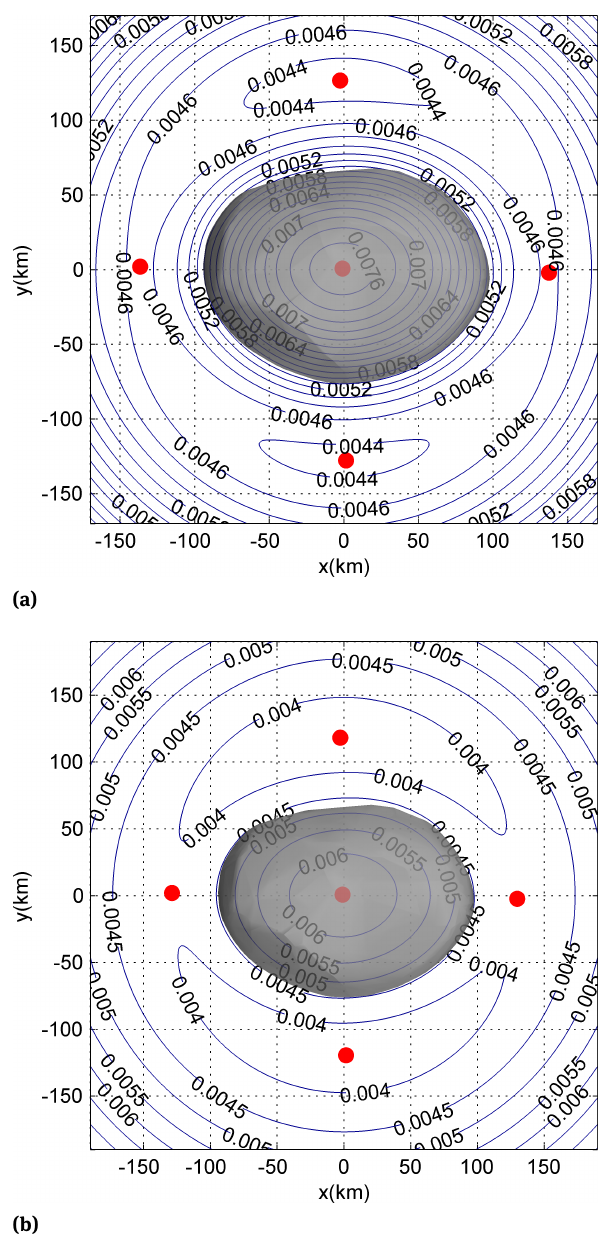
Figure 6. The locations of projections of equilibrium points in the equatorial plane during the variety of density. (a) ω =1.0 ω 0 , ρ =1.1 ρ 0 ; (b) ω =1.0 ω 0 , ρ =0.9 ρ